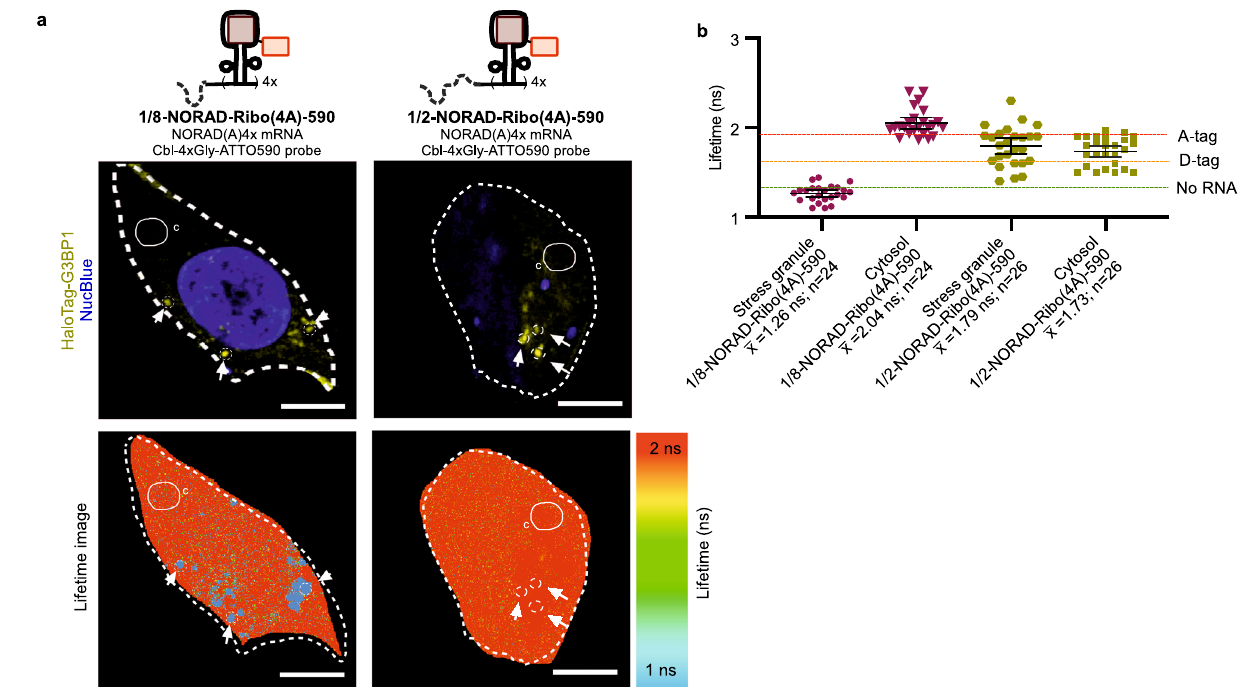
Fig.6 |Quanti fi cationofRNArecruitmenttostressgranules(SGs)fordifferent tagged RNAs via Riboglow-FLIM. a Representative images of arsenite-stressed HaloTag-G3BP1 U-2 OS cells producing truncated versions of Riboglow-tagged NORAD. Cells produce the SG marker protein G3BP1 from the chromosome to identify SGs via HaloTag ligand JF646 (top panel, fl uorescence intensity image, yellow areas indicate G3BP1). Nucleus was identi fi ed using NucBlue (blue). White arrows point to HaloTag-G3BP1 marked SGs. Smaller white circle labeled C indi- cates a representative ROI of the cytosol. Bottom panel: pixel-by-pixel component